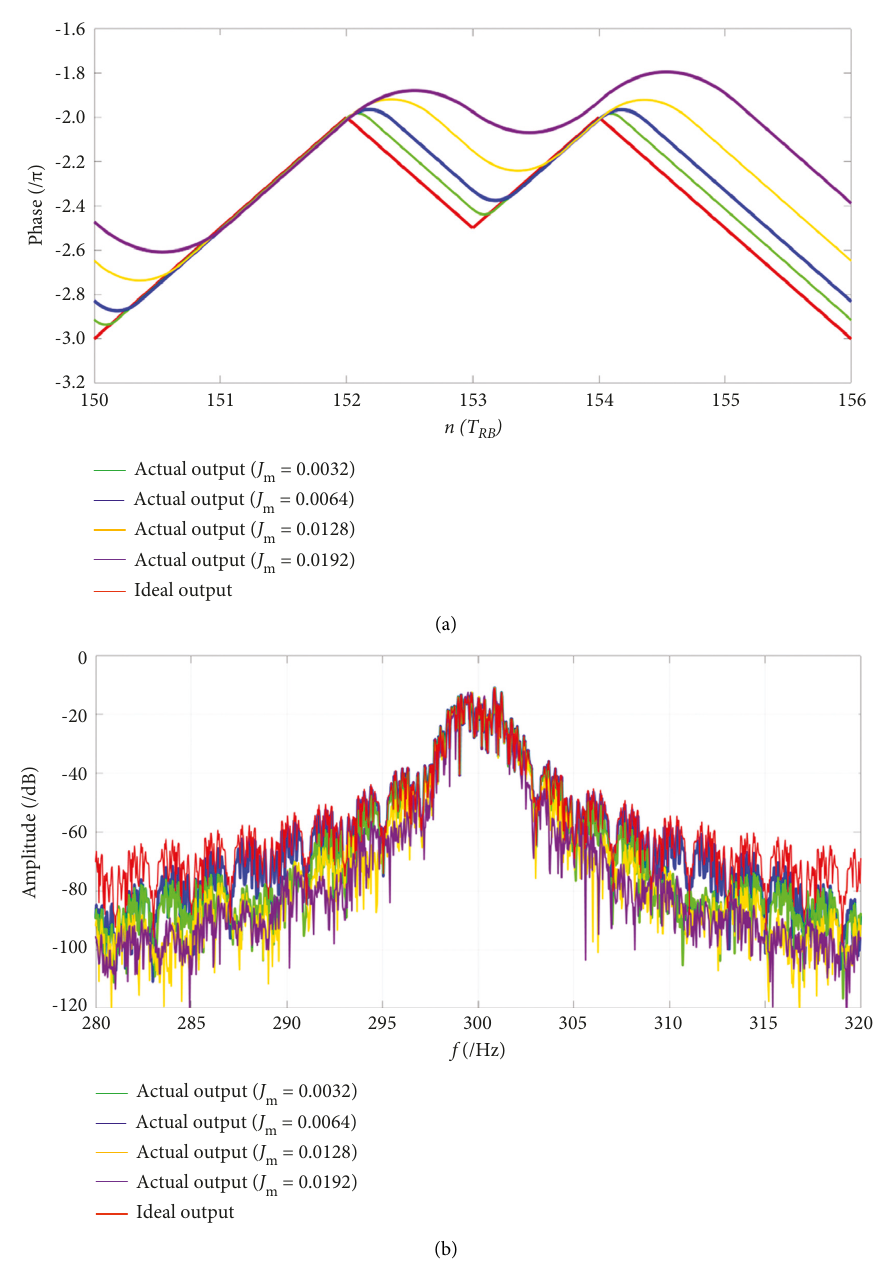
Figure 10: Simulation results of the phase and spectrum affected by different inertias (a) phase; (b) output signal